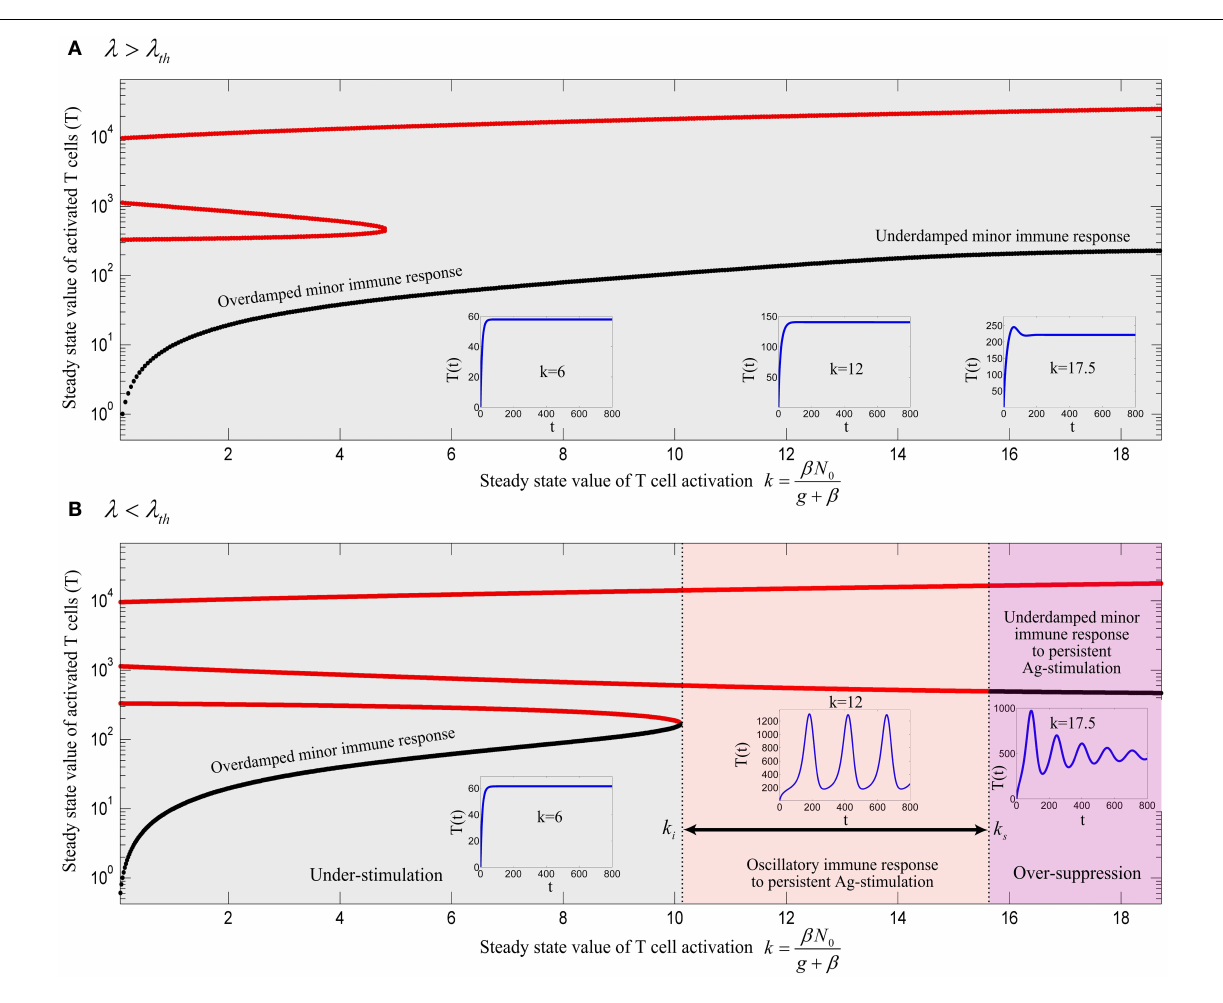
FIGUREA2 | Bifurcation diagram of model (A73) with Hill-function parameters n = 4 and h = 1 using k as the bifurcation parameter with (A) λ = 0.0016 and (B) λ = 0.0008 . Stable and unstable equilibrium points are drawn by black and red solid lines, respectively.The stable limit cycles are not shown for all value of k i < k < k s except for k = 12. Depending on the values of λ and k , an immune response is not initiated (gray), is initiated (red) or